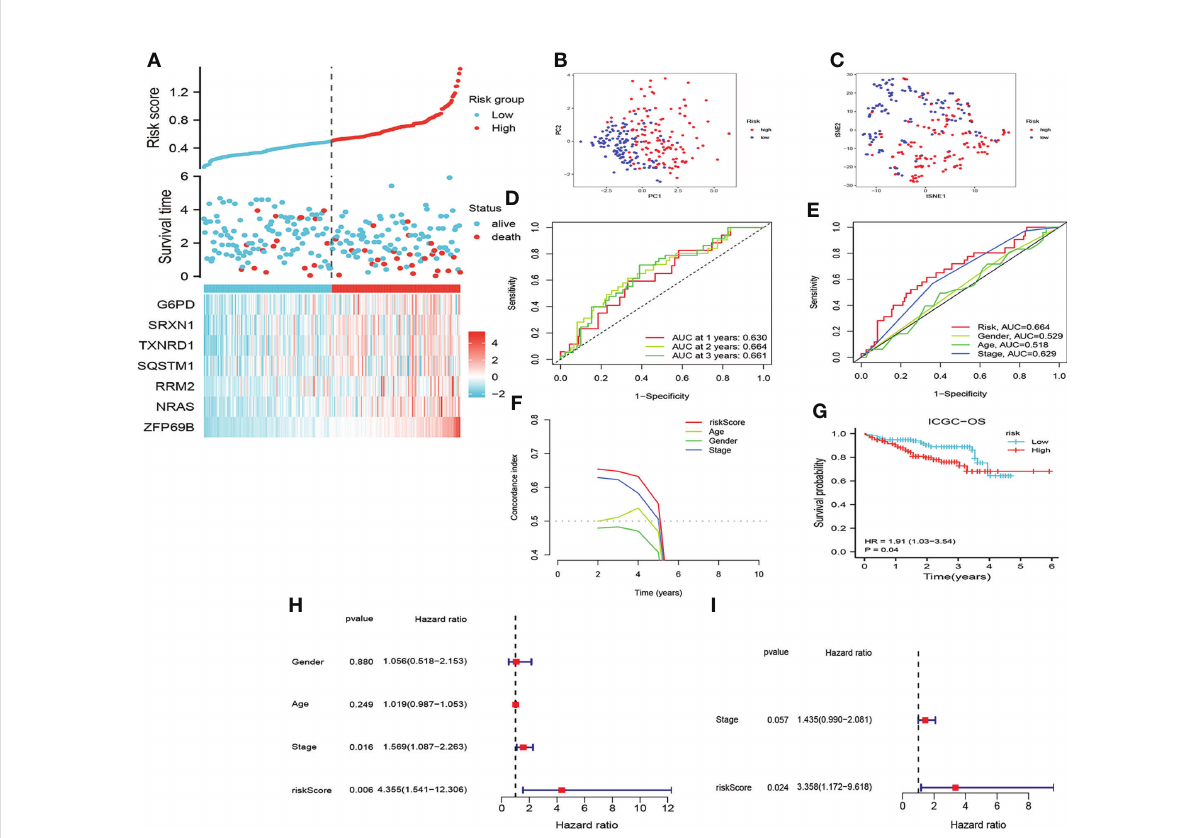
FIGURE 4 Assessment of the prognostic signature (CRFs) in ICGC. (A) Survival status distribution. (B) PCA plot. (C) t-NSE plot. (D) timeROC curve of the risk score. (E) ROC curve of the age, gender, stage, and risk scores. (F) C-index curve of the age, gender, stage, and risk scores. (G) KM curves of OS. (H) Univariate Cox regression analysis of the age, gender, stage, and risk score in ICGC. (I) Multivariate Cox regression analysis of the stage and risk scores in